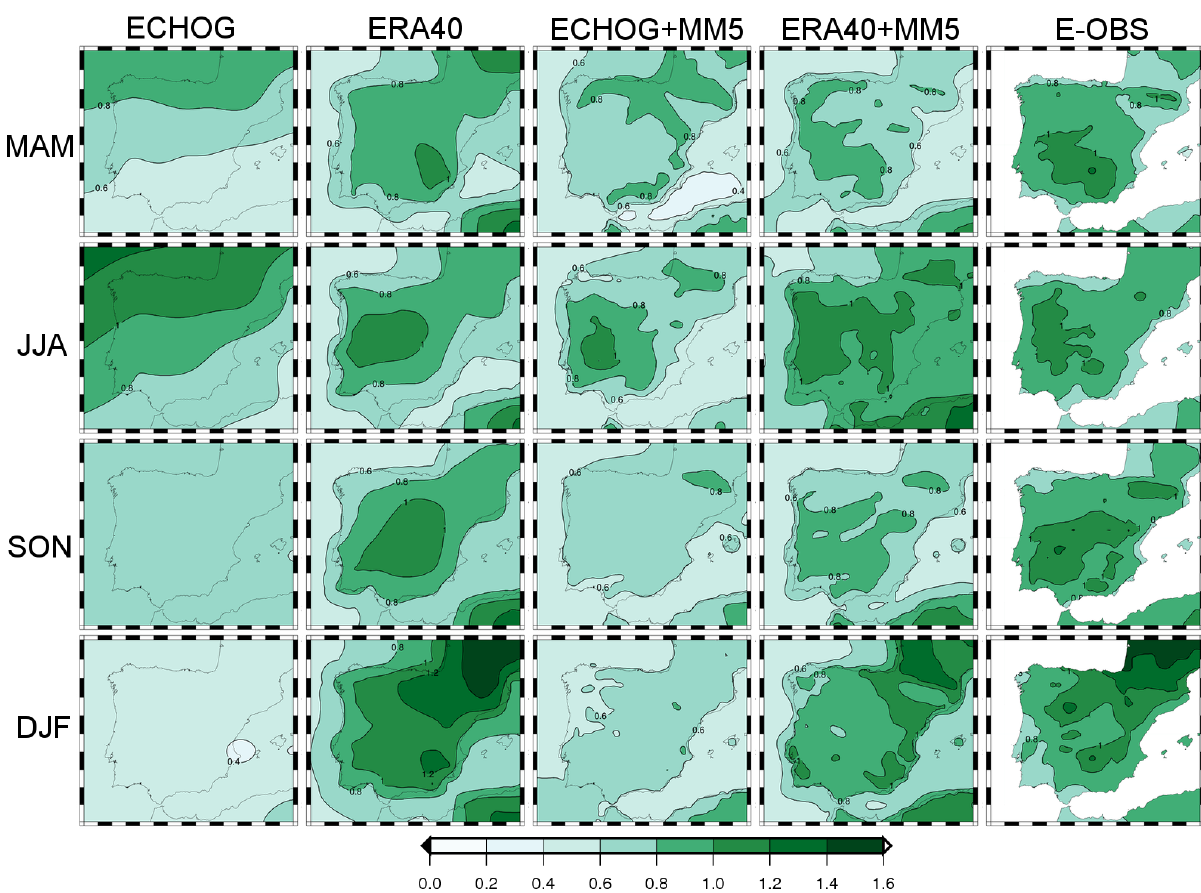
Fig. 6. Standard deviation (in ◦ C) of seasonal mean series of SAT in the period 1961–1990 for ECHO-G, ERA40, and MM5 nested to both (by columns) in all the seasons (by rows). Last column depicts the values for the E-OBS data base. All fields have been interpolated to a 7 minutes regular grid to ease the visual comparison.